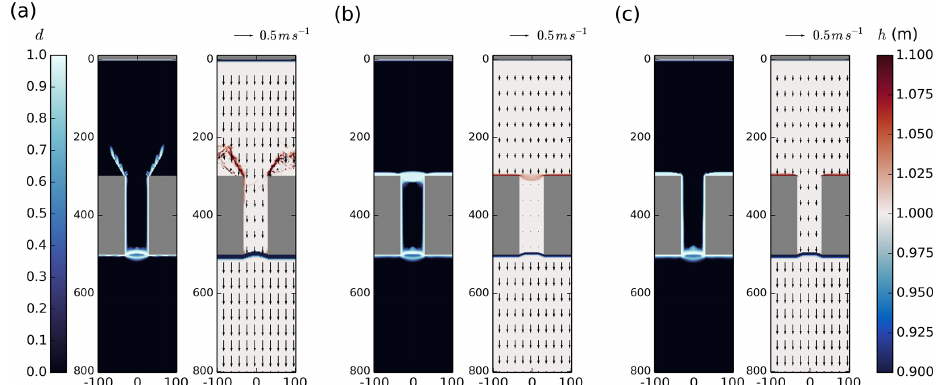
Figure 13. Spatial distribution of the damage field at the end of Stage D (left panels) and the sea ice thickness and velocity fields at the end of the simulation (right panels) for different compressive strength criteria: (a) σ c = 25 . 0kNm − 1 . (c) σ c 0